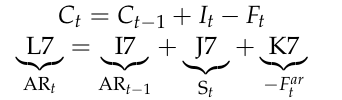
Figure 37. Cell I7 contains the formula for picking up the Account Receivable AR as of period 𝑡 = 0 (“SinglePeriod” sheet).